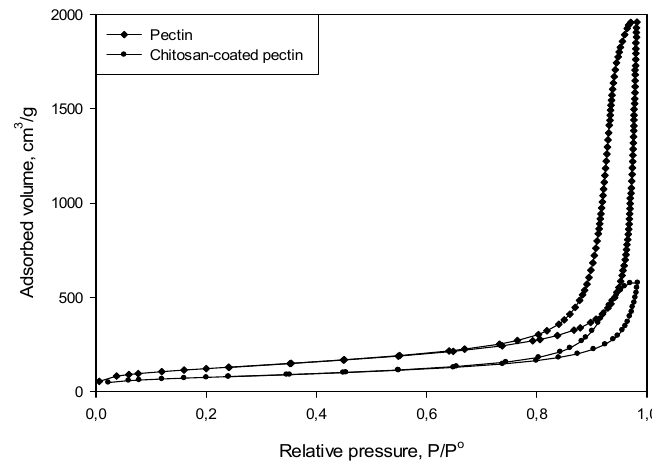
Figure 3. Adsorption–desorption isotherms for pectin aerogel and chitosan-coated pectin aerogels .